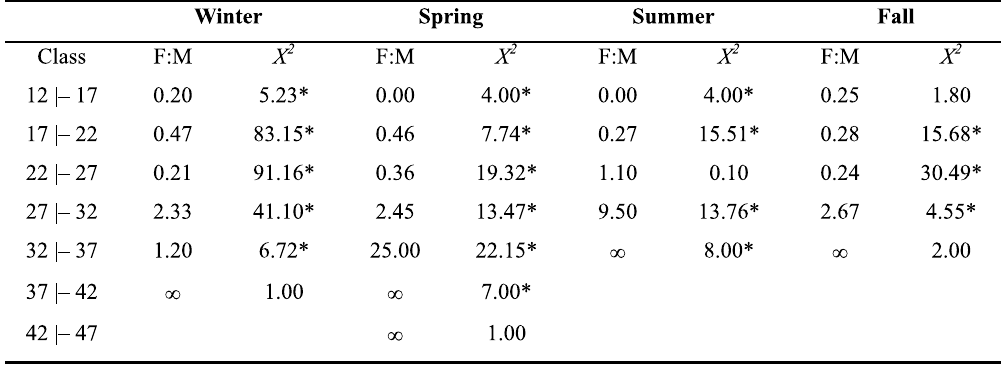
Table 3: Number of Menticirrhus littoralis by gender and reproductive status captured each month (June 1997 to May